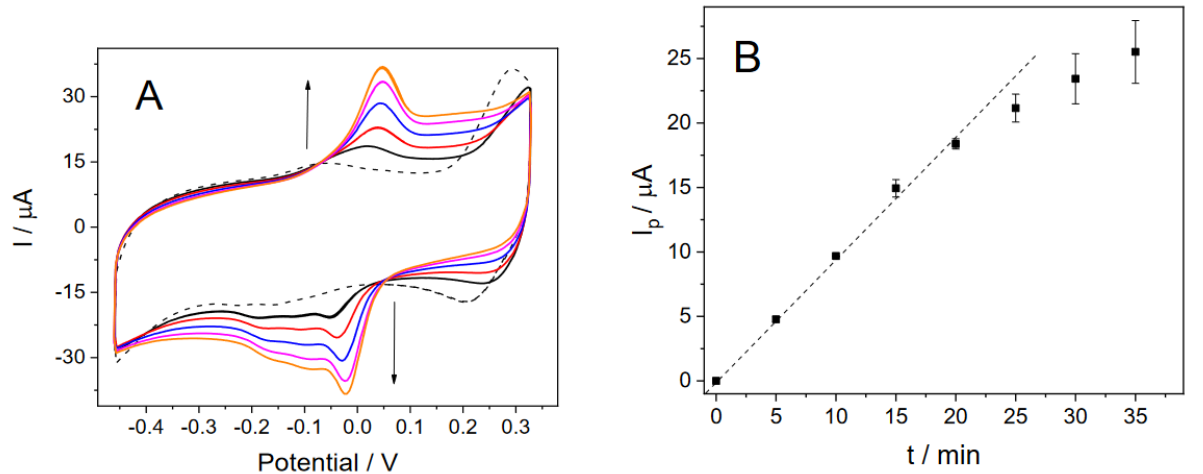
Figure 2. ( A ) Cyclic voltammograms recorded with ALP@AETAC-modified electrode in trizma buffer solution containing 0.5 mM HQ2P at 100 mV s − 1 under room atmosphere. Number of cycles: 1 (dashed black line), 19 (black line); 38 (red line); 76 (blue line); 114 (magenta line); 152 (orange line). ( B ) Evolution of the oxidation peak intensity as a function of the time.